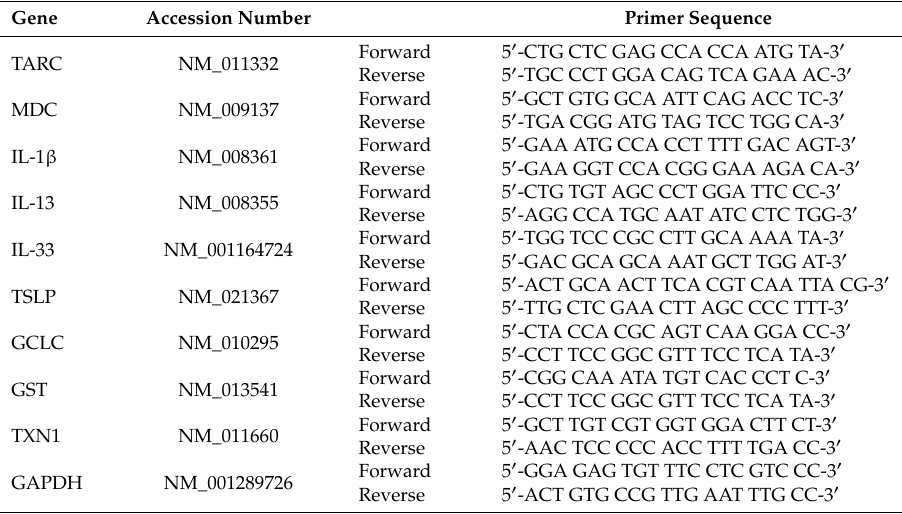
Table 1. Sequence of real-time PCR